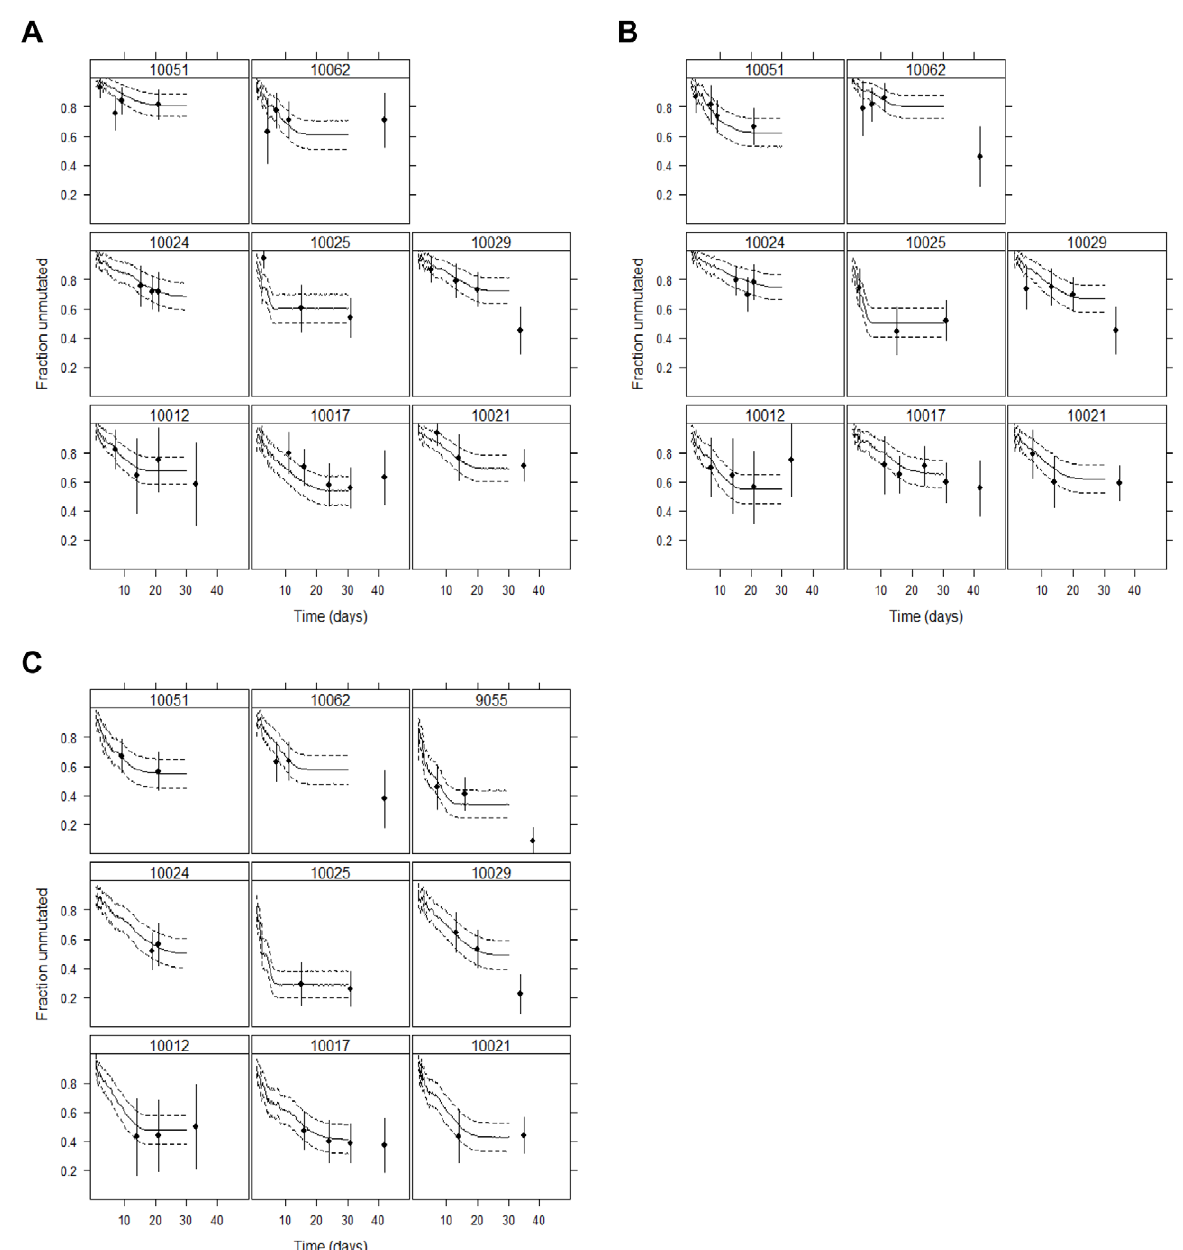
Figure 2. Fraction of sequences identical to the T/F virus over time. The symbols represent the SGA data and corresponding binomial 95% CI; the solid line is the average from 100 simulations and the dashed line the 95% CI for the proportion [64]. (A) data for the first quarter (Q1) of the 5 9 HCV genome (note that for subject 9055, there is no data for Q1 or Q2); (B) data for the second quarter (Q2) of the 5 9 HCV genome; (C) data for the 5 9 half of the HCV genome.